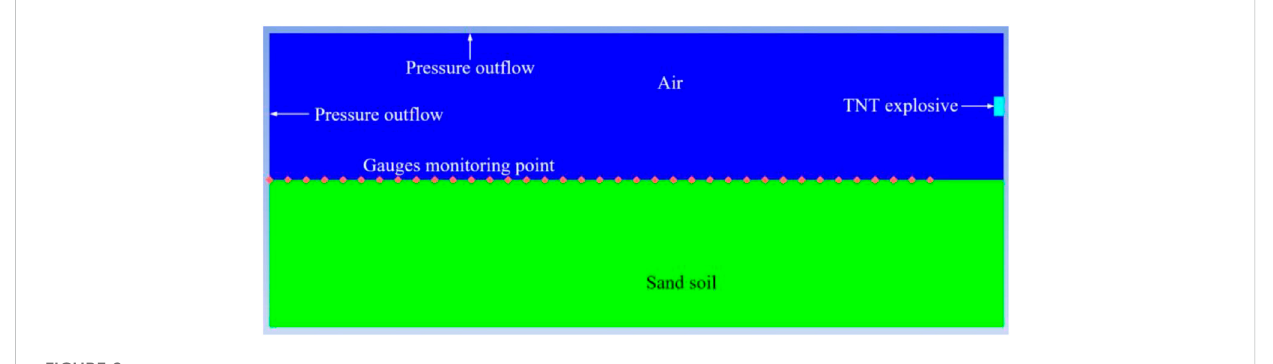
FIGURE 2 Shock wave pressure fi nite element numerical simulation model structural schematic diagram.